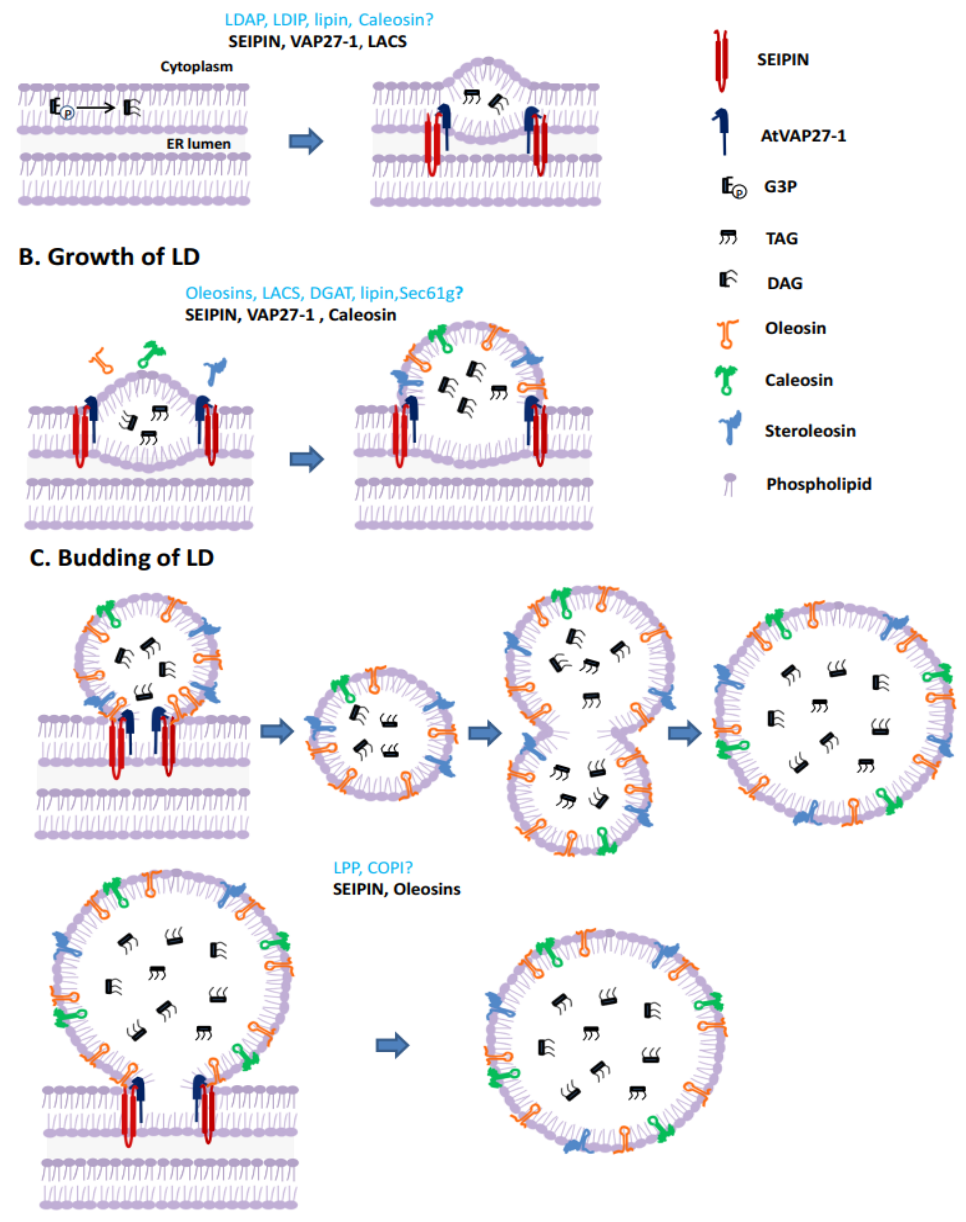
Figure 1. Models of lipid droplet biogenesis in plant (using LDs in seeds as an example). ( A ) Nu- cleation of LD. Neutral lipids (mainly TAG) nucleate and a lens-like structure is formed in the ER membrane. ( B ) Growth of LD. LD-specific proteins synthesized in the cytoplasm migrate toward sites of TAG accumulation and are inserted into the ER. The size of the neutral lipid core increases and protrudes due to the accumulation of TAG. ( C ) LD budding. After reaching a critical size, a nearly globular LD surrounded by an ER monolayer is formed and then splits from the mother membrane. Alternatively, nascent small LDs fuse to form large ones after budding.